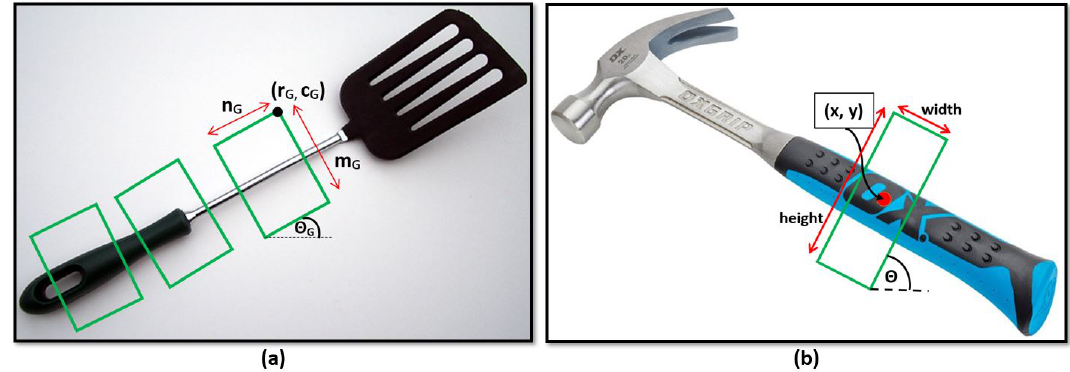
Figure 2. Grasping rectangle representations. ( a ) The representation by Jiang et al. [30]: Top vertex ( r ) , length m G , c G G , width n G and its angle from the x-axis, θ G for a kitchen utensil. There can be multiple ground truth grasps defined as shown. ( b ) The simplified representation by Redmon et al. [19] for a hammer, showing its grasp centre at ( x , y ) oriented by an angle of θ from its horizontal axis. The rectangle has a width and height of w and h